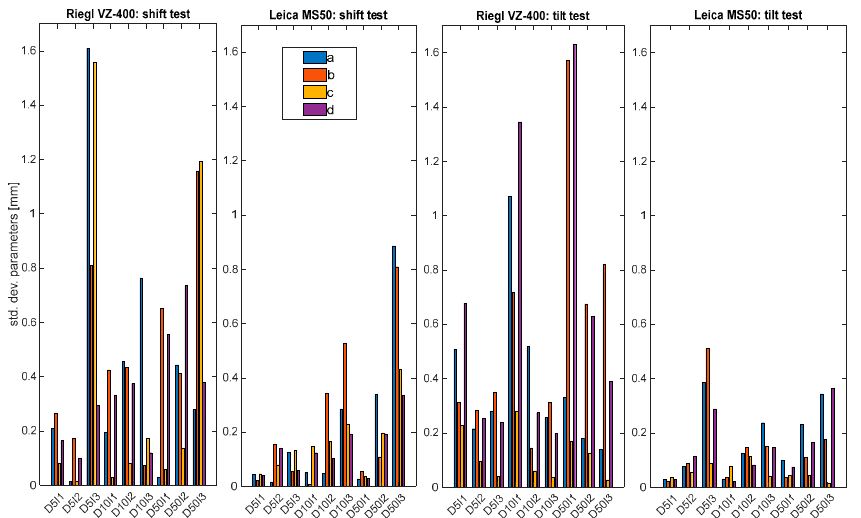
Figure 10. Precisions of the plane parameters.